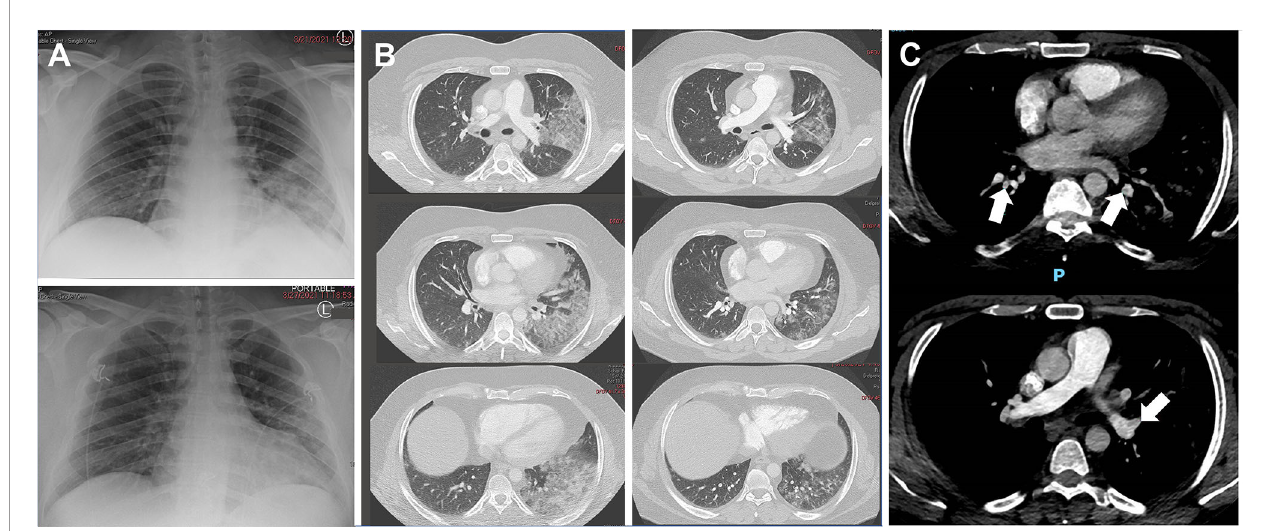
FIGURE 2 | Temporal evolution of radiographic abnormalities in Patient 1 during the course of COVID-19. (A) Chest X-ray demonstrating left lower lung airspace disease on admission at the NIH Clinical Center (upper panel) and radiographic improvement noted 7 days later (lower panel). (B) Chest CT showing left>right pulmonary in fi ltrates on admission at the NIH Clinical Center (Left panels) and radiographic improvement noted 7 days later (right panels). (C) Chest CT angiography on admission at the NIH Clinical Center showing small pulmonary emboli (white